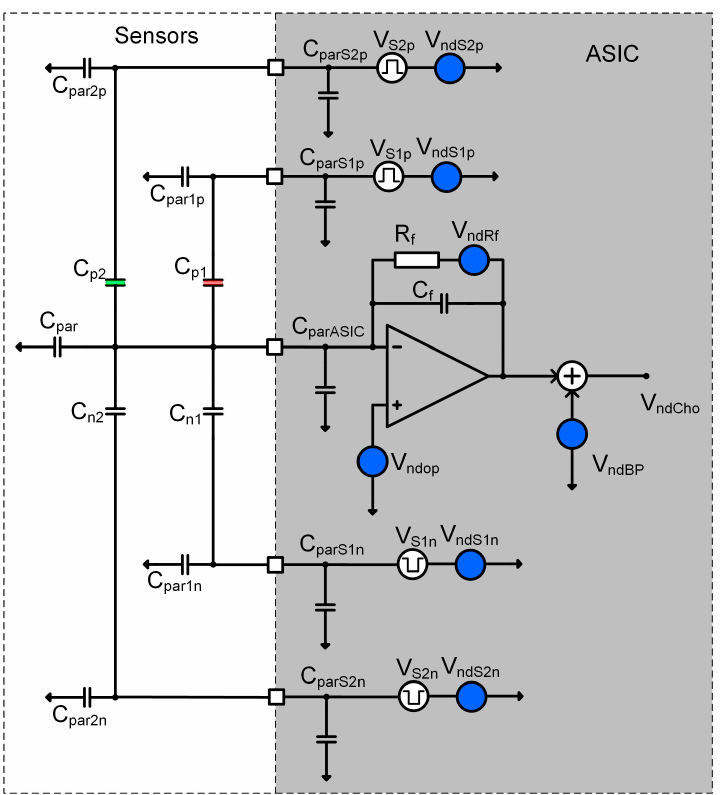
Figure 10. Simplified circuit diagram of one-half of the charge amplifier that includes two differential sensors. Most important parasitic capacitors are marked on that picture together with most important noise sources.